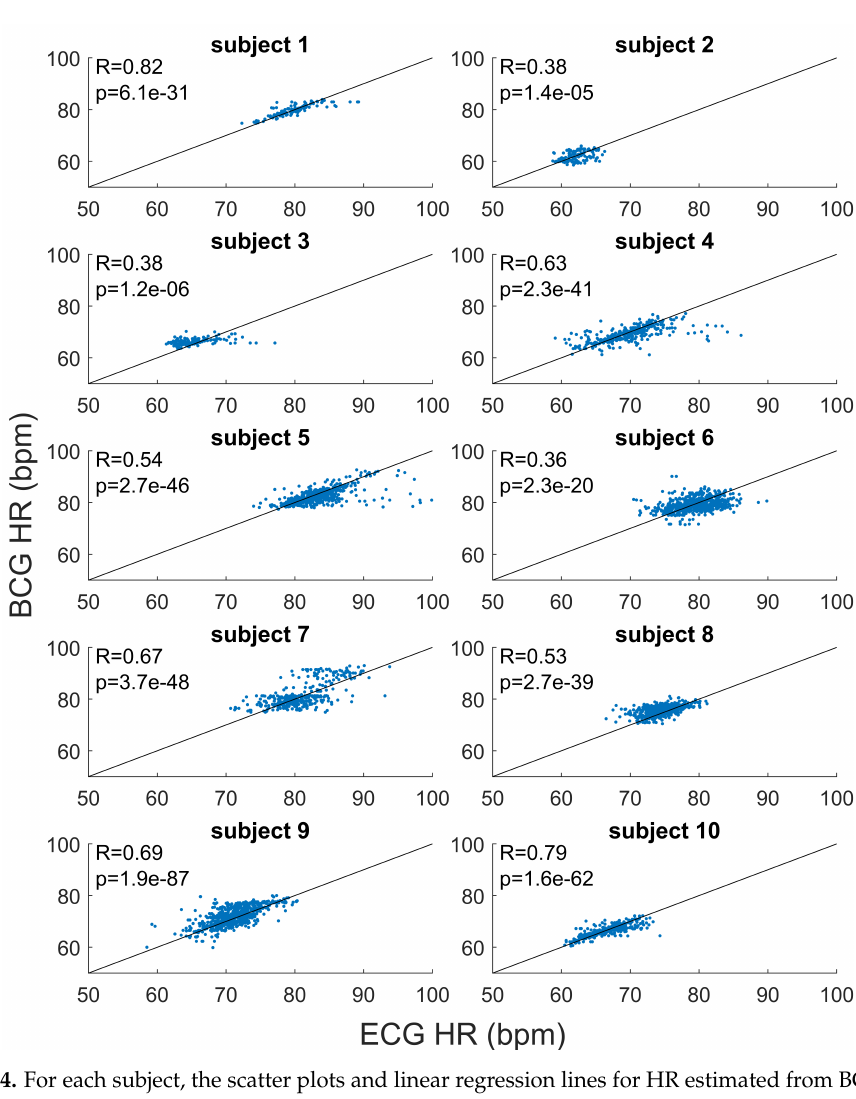
Figure 4. For each subject, the scatter plots and linear regression lines for HR estimated from BCG and ECG are reported. The correspondent coefficient of regression (R) and p -values ( p ) are shown.